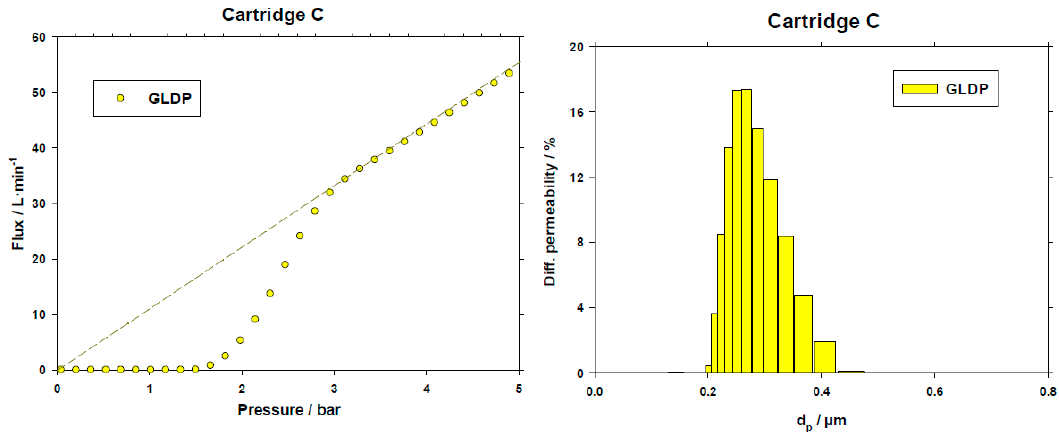
Figure 3. Example of a GLDP porosimetric curve and resulting permeability distribution for a coupon from C cartridge.